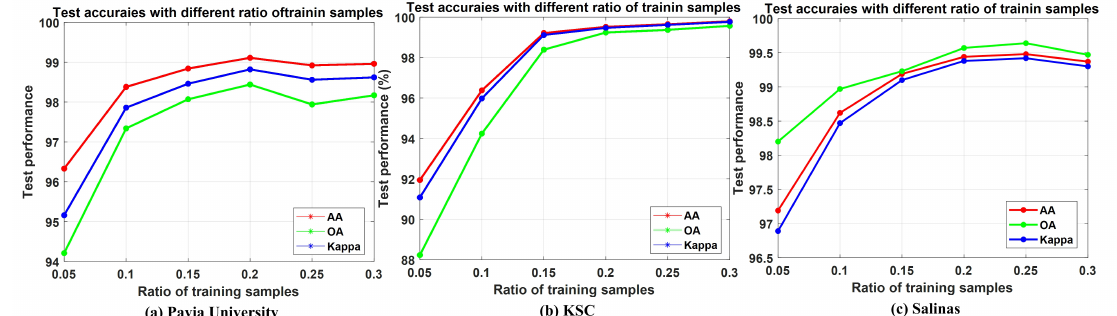
Figure 7. Test performance with different ratio of training samples on different hyperspectral datasets. ( a ) Pavia University. ( b ) KSC. ( c )